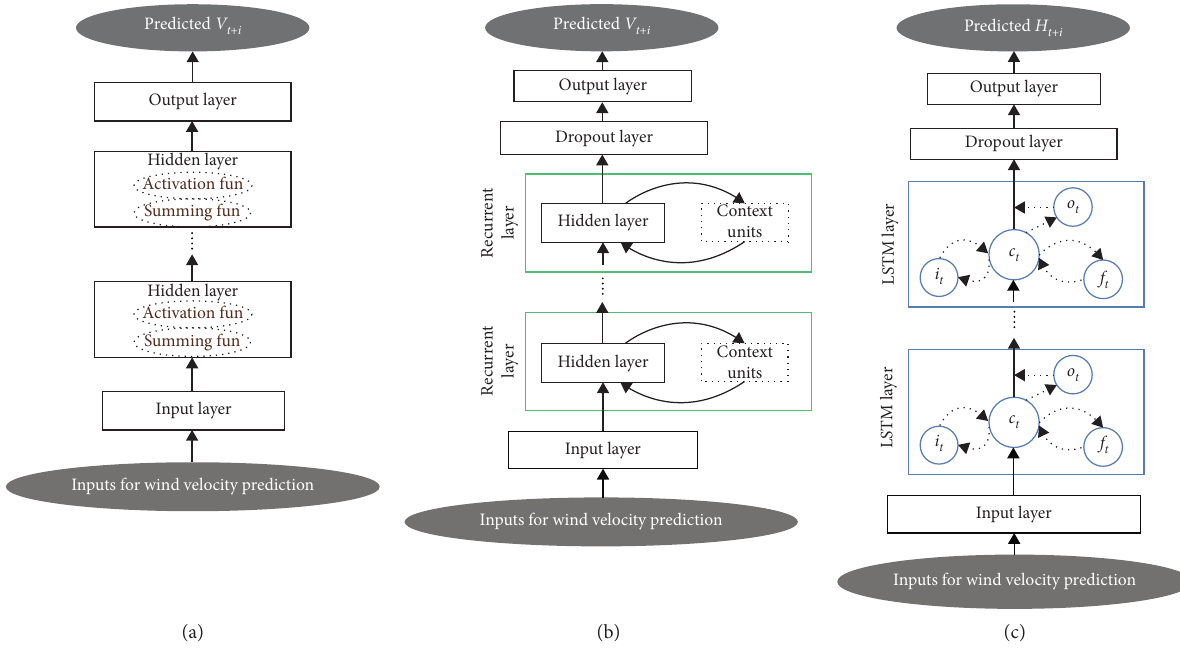
Figure 2: Architecture of (a) MLP, (b) DRNN, and (c) stacked LSTM neural